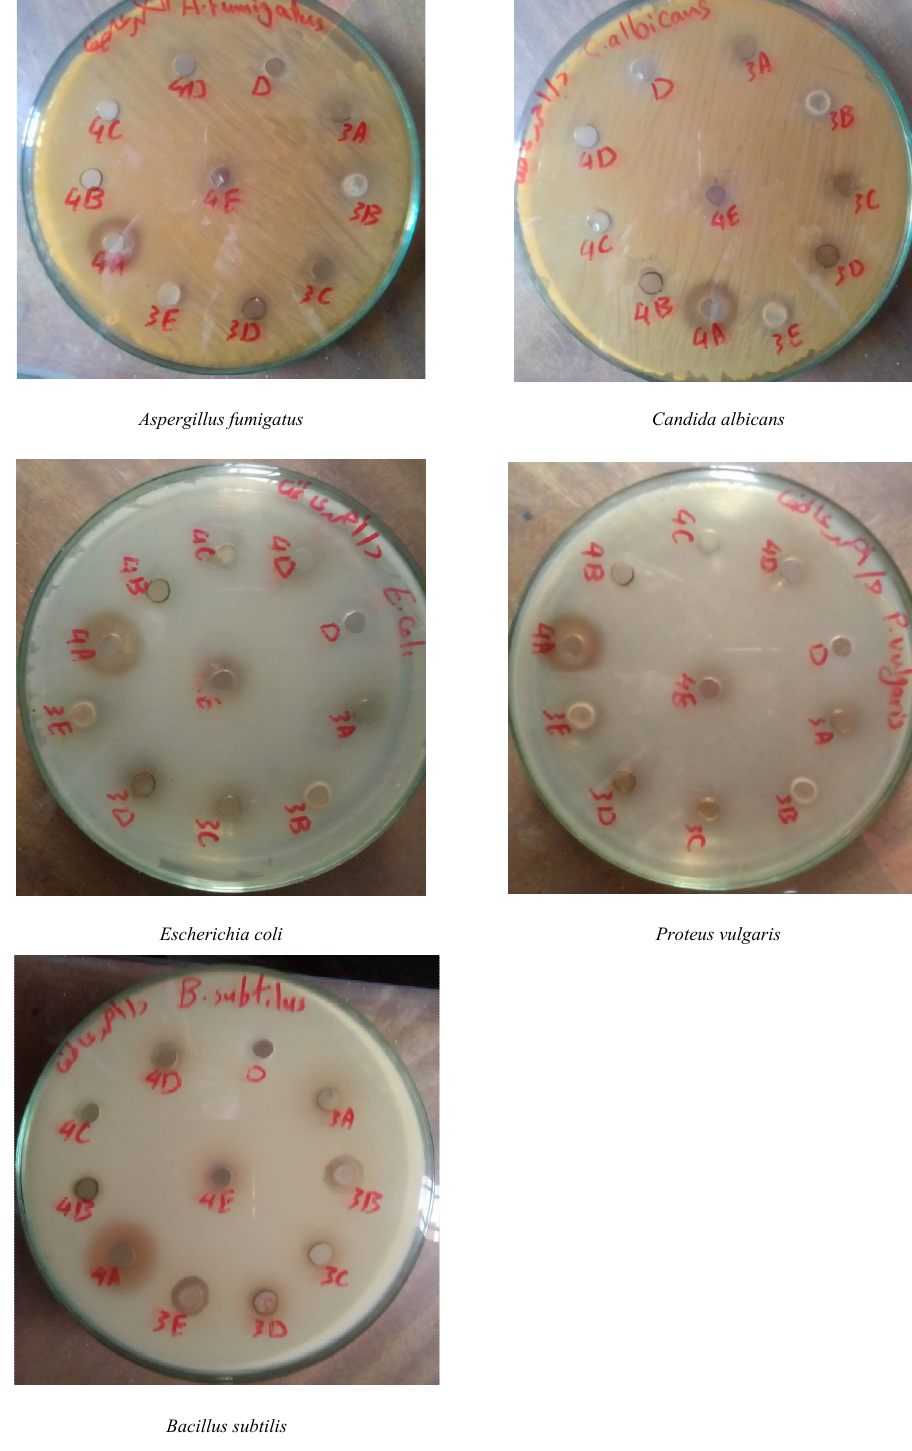
Figure 4. Antimicrobial activity of the different extracts of Taif’s rose. 3: flowers, 4: solid distillation wastes, A: methanol extract, B: ethanol extract, C: boiled water, D: cold water, E: warm water.